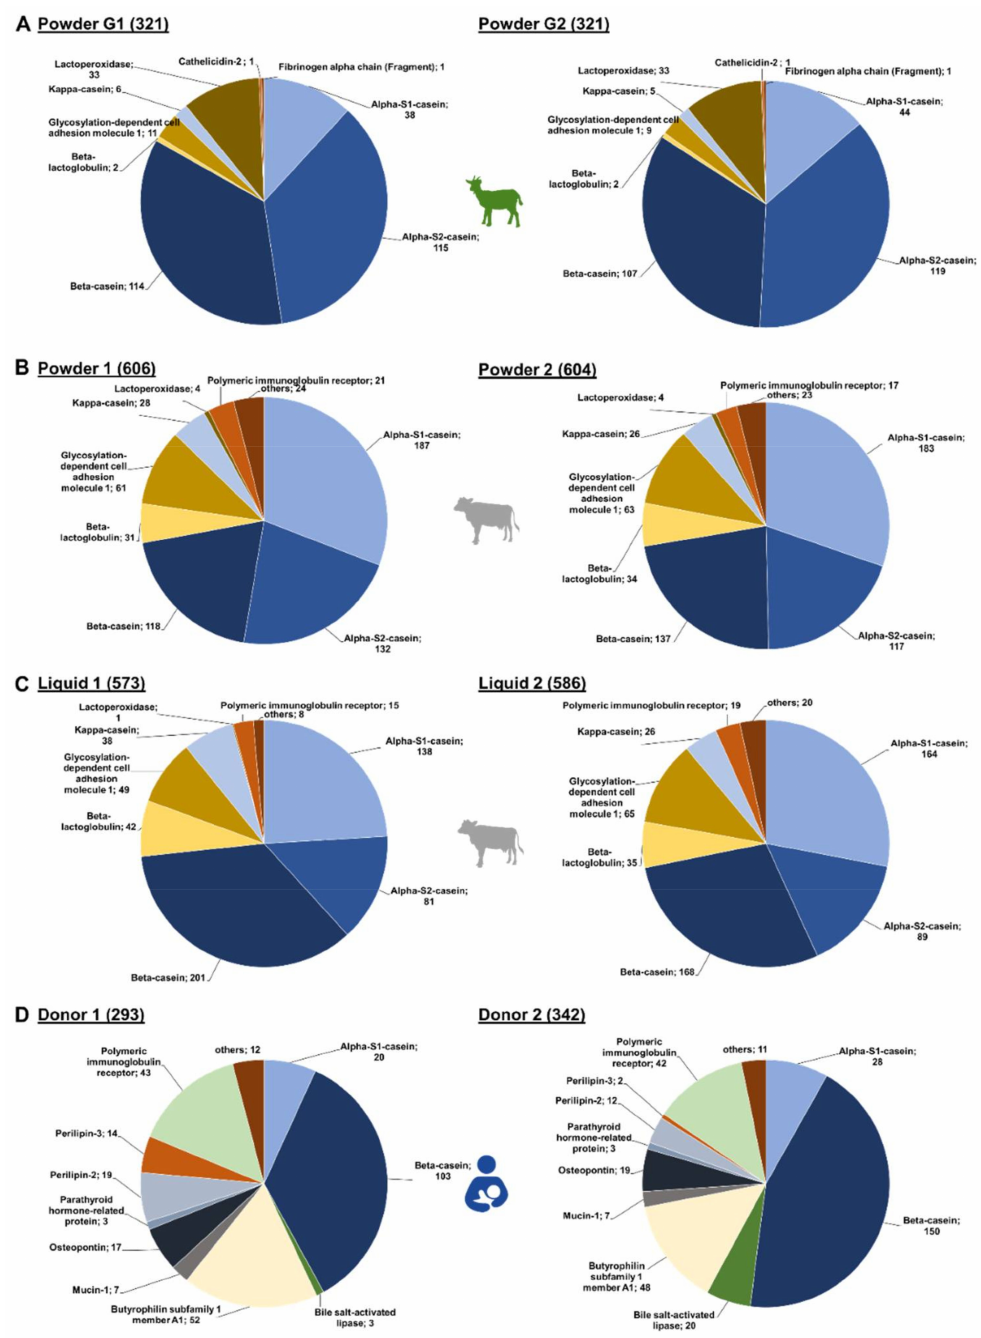
Figure 2. Number of peptides identified for each source protein in the individual brands of ( A ) goat (Powder G1 and G2), ( B ) cow milk-based powdered IF (Powder 1, Powder 2) and ( C ) cow milk-based liquid IF ( Liquid 1, Liquid 2) as well as in ( D ) human milk (Donor 1 and Donor